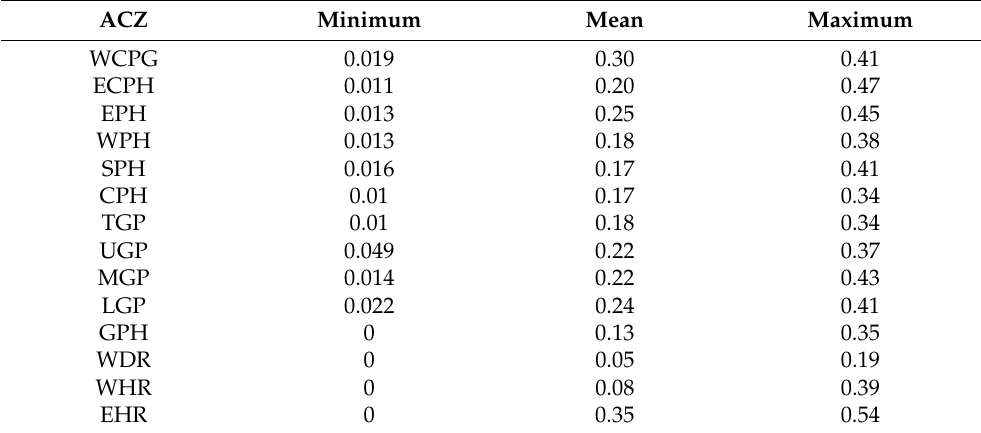
Table 3. Minimum, mean and maximum SIF values in each of the agro-climatic zone during the summer